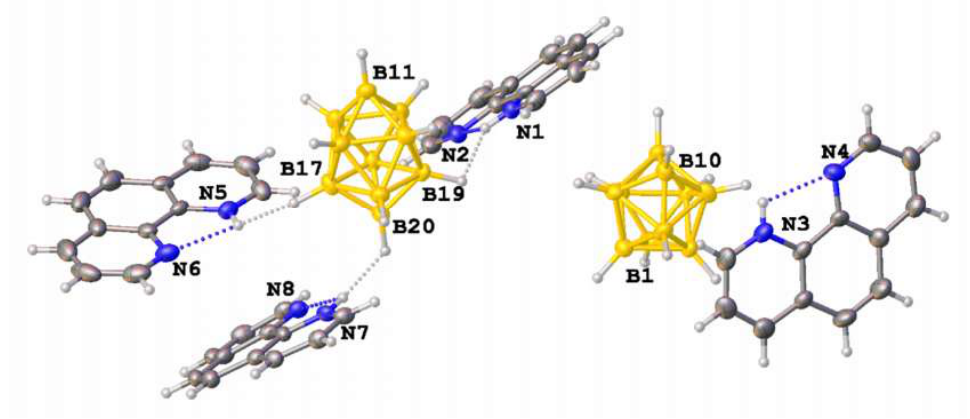
Figure 4. Asymmetric unit of 4 in representation of atoms with thermal ellipsoids (p = 50%). H-bonds are depicted with dotted lines.